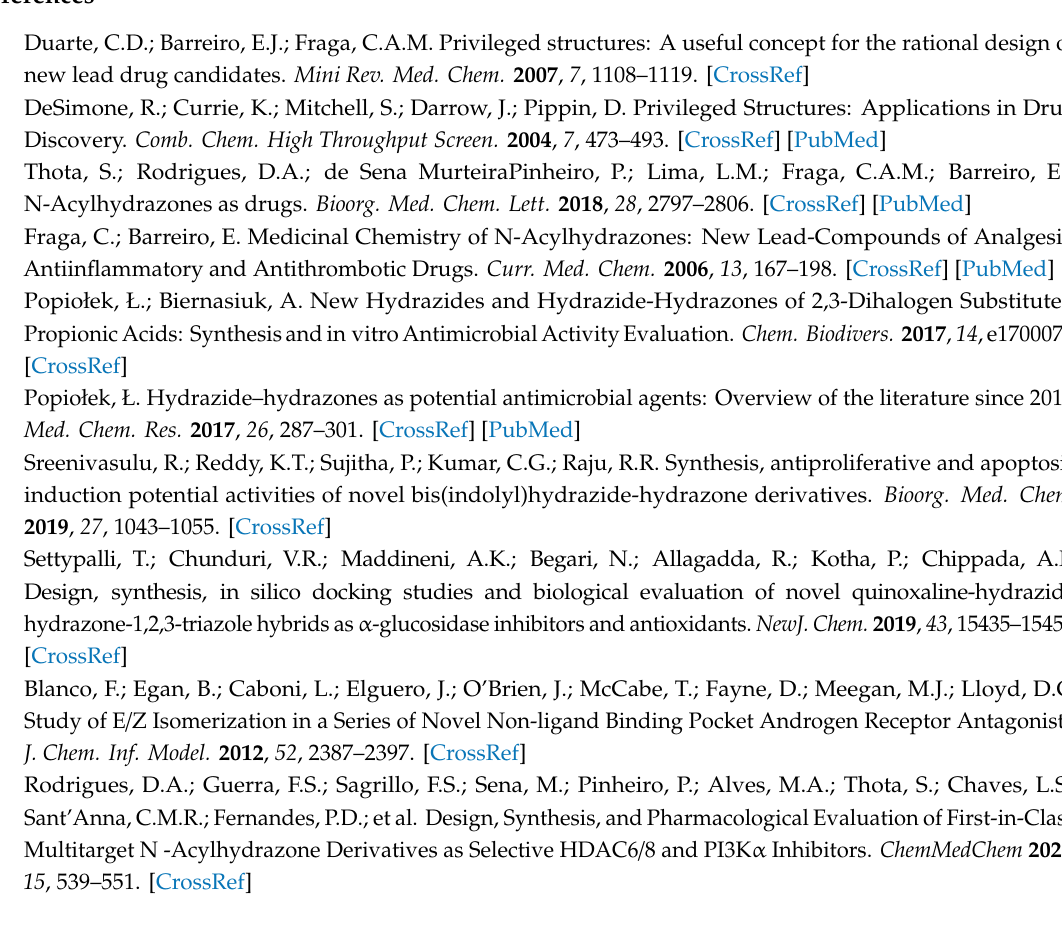
Figure SM-1. Plot of predicted free energies of binding versus the experimental a ffi nities. Validation of the docking procedure performed with AutoDock 4.2.6 and AutoDock Vina. Table SM-1. Quality of binding pose prediction (Auto Dock 4.2.6). Table SM-2. Quality of binding pose prediction (AutoDock Vina). Results of molecular modelling for selected compounds. Table SM-3. Comparison of docking poses found by AutoDock and AutoDock Vina. NMR assignments for selected